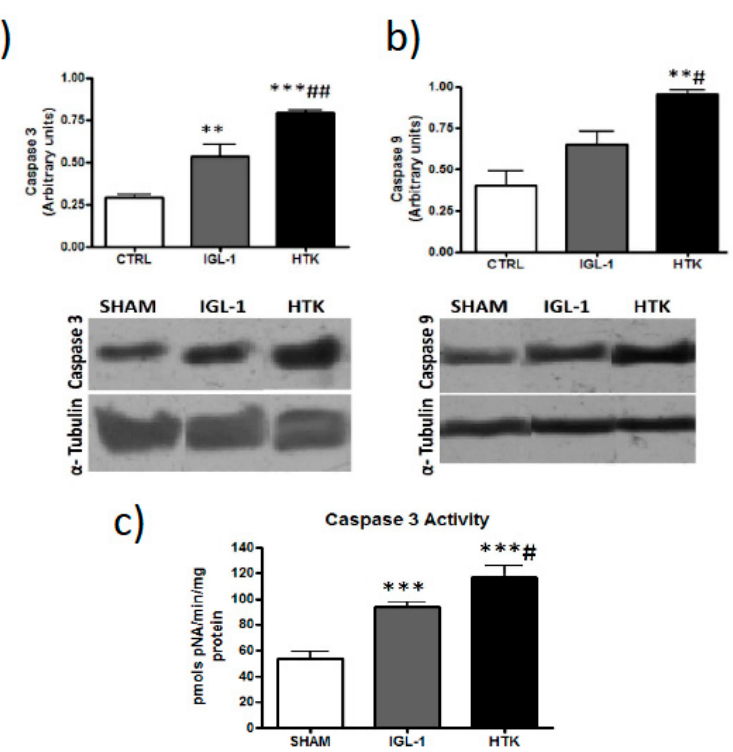
Figure 5. Apoptosis (measured as cleaved caspase 3 ( a ), caspase 9 ( b ) and caspase 3 activity ( c )) in liver grafts preserved in IGL-1 and HTK vs controls. Bar graphs represent the mean ± SD. ** p < 0.005 vs. SHAM, *** p < 0.0005 vs. SHAM, # p < 0.05 vs. IGL-1, ## p < 0.005 vs. IGL-1.